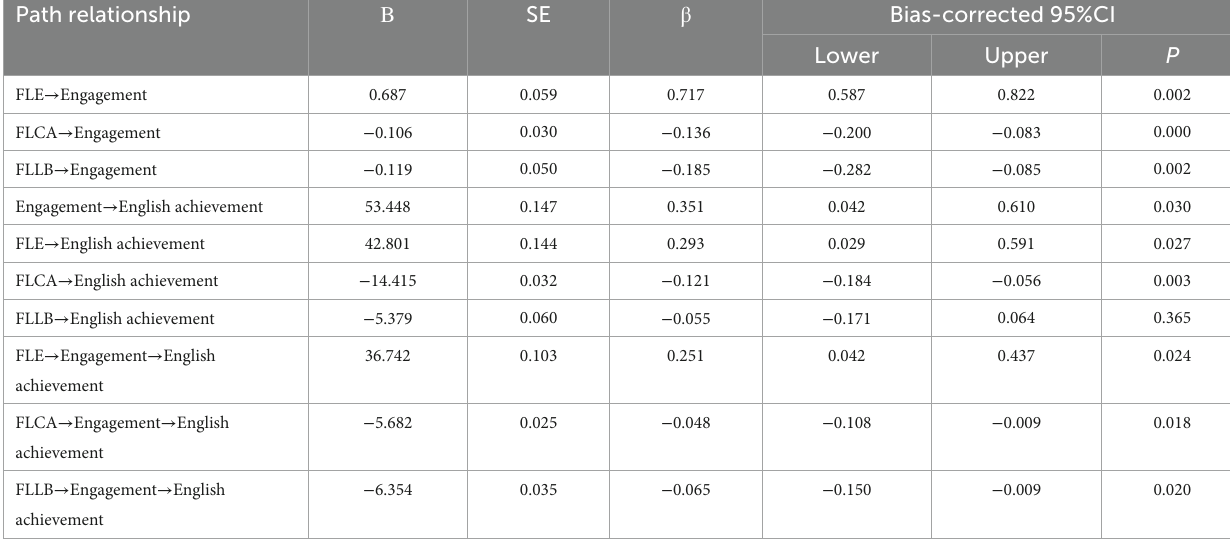
TABLE 4 Unstandardized and standardized path